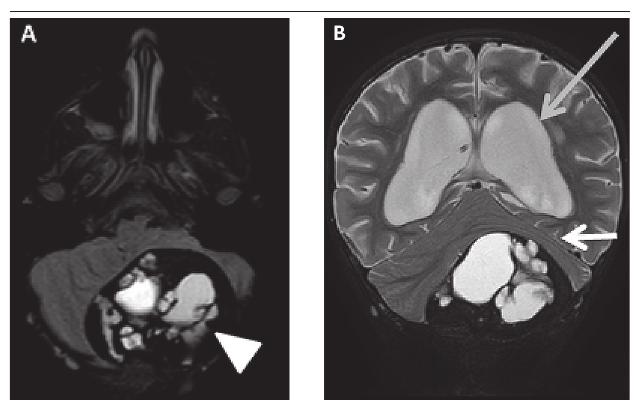
FigurE 1 − A) MRI in the FLAIR sequence in the axial section demonstrating well-defined extra-axial mass in the posterior fossa to the left, traversing the occipital bone posteriorly, projecting to adjacent soft parts with extensive internal hemorrhage (arrowhead), pressing the cerebellar hemispheres; B) MRI in the T2 SPIR sequence in the coronal section demonstrating well-defined extra-axial mass in the posterior fossa to the left, projecting to adjacent soft parts with extensive internal hemorrhage, pressing the cerebellar hemispheres (thin white arrow) and distorting the fourth ventricle with severe upstream hydrocephalus (gray arrow) MRI: magnetic resonance imaging; FLAIR: fluid attenuated inversion recovery; SPIR: spectral presaturation with inversion recovery.